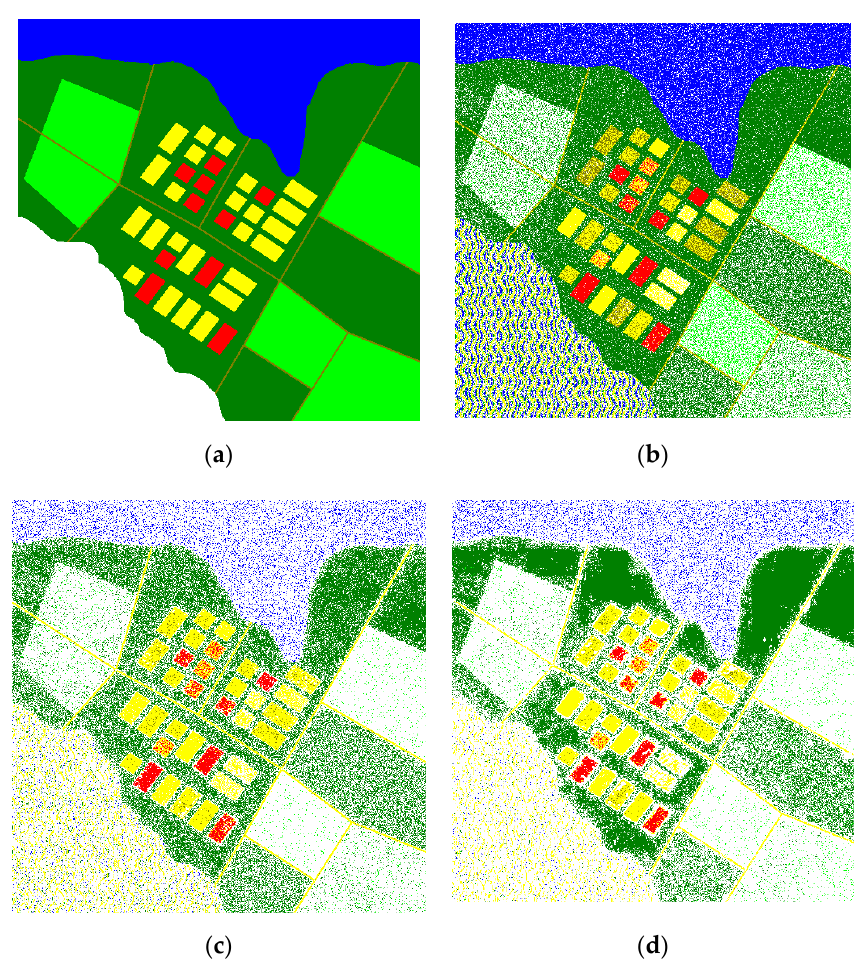
Figure 3. Classification results: true map ( a ); classification map for original image ( b ); classification map for image compressed with PSNR-HVS-M = 36 dB ( c ); classification map for image compressed with PSNR-HVS-M = 30 dB ( d ).